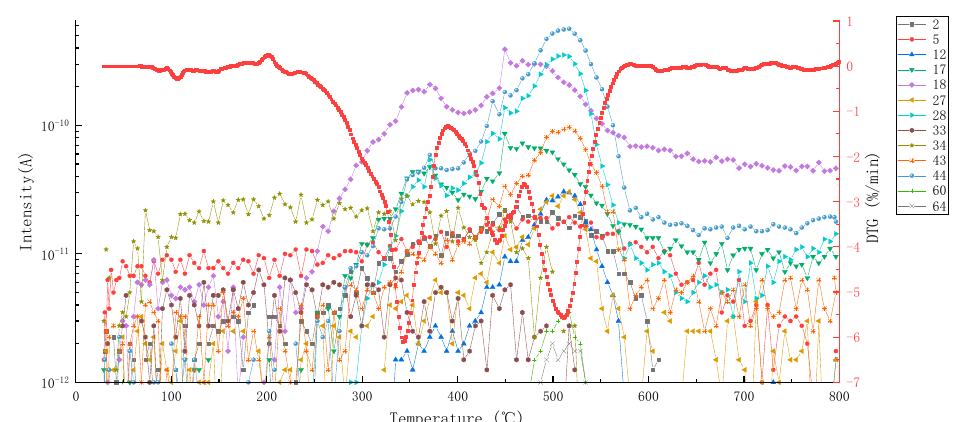
Figure 2. MS-DTG curve of main volatiles from pyrolysis combustion of epoxy asphalt. Table 4. Distribution of volatile matter from pyrolysis combustion of epoxy asphalt.